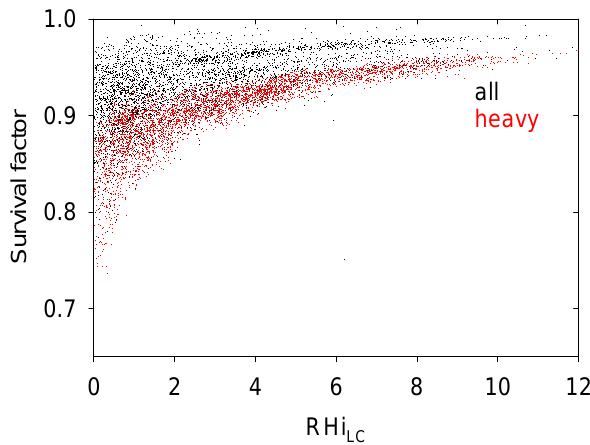
Fig. 5. Survival factor for ice mass due to adiabatic wake vortex sinking versus the critical relative humidity over ice RHi LC required for contrail formation, for meteorology over the North Atlantic for 6–9 June 2006. Each point corresponds to an aircraft with proper- ties representing aircraft types in the traffic input (black) or with properties of an heavy aircraft